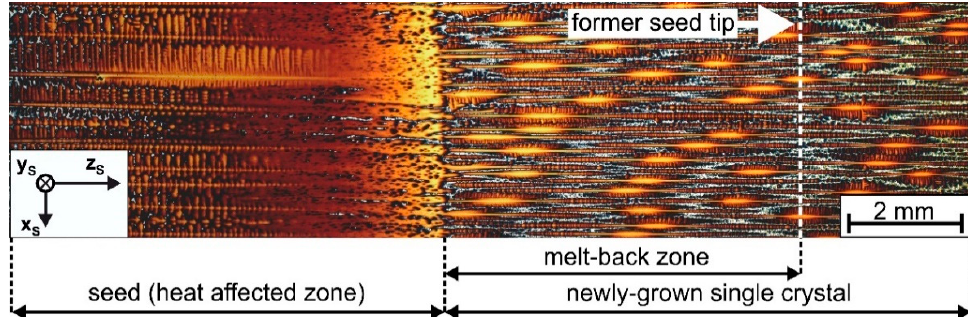
Figure 1. Transition zone between back-melted seed and newly-grown SX (optical micrograph, longitudinal cross section). Modified reprint from Reference [62], with permission from Elsevier. In the present work, a similar sample was investigated by a quantitative three-dimensional tomographic